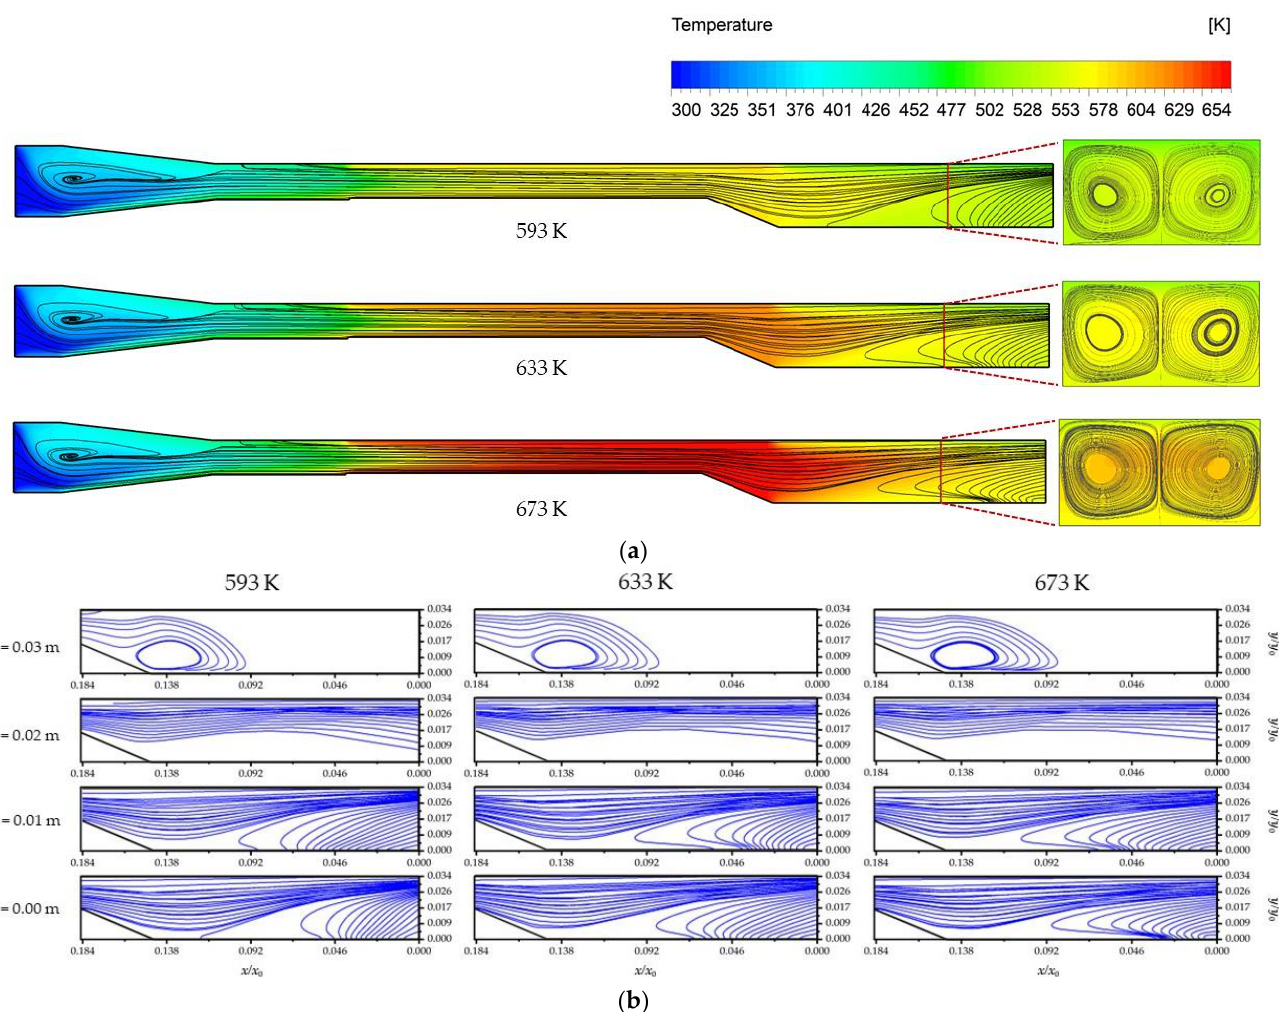
Figure 7. The flow structure ( a ) coupled with the temperature contour at the mid-plane of the reactor and ( b ) at symmetric planes of z = 0 m, 0.01 m, 0.02 m and 0.03 m with temperatures of 593 K, 633 K and 673 K.